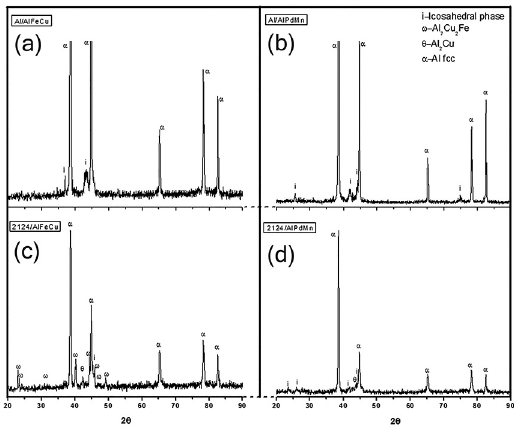
Figure 2: XRD patterns of the aluminum and 2124 aluminum alloy composites. (a) Al/AlCuFe. (b)Al/AlPdMn. (c) 2124/AlCuFe. (d) 2124/AlPdMn.